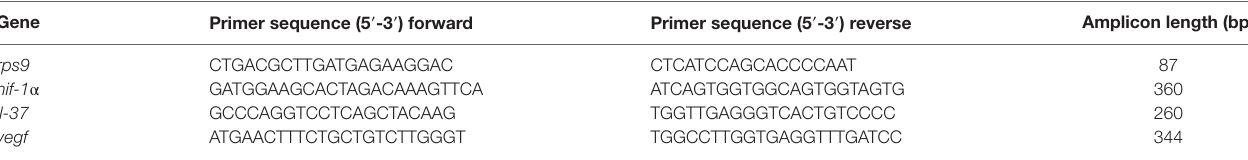
taBLe 1 | oligonucleotide primers used in rt-qpCr. Gene primer sequence (5 ′ -3 ′ ) forward primer sequence (5 ′ -3 ′ )